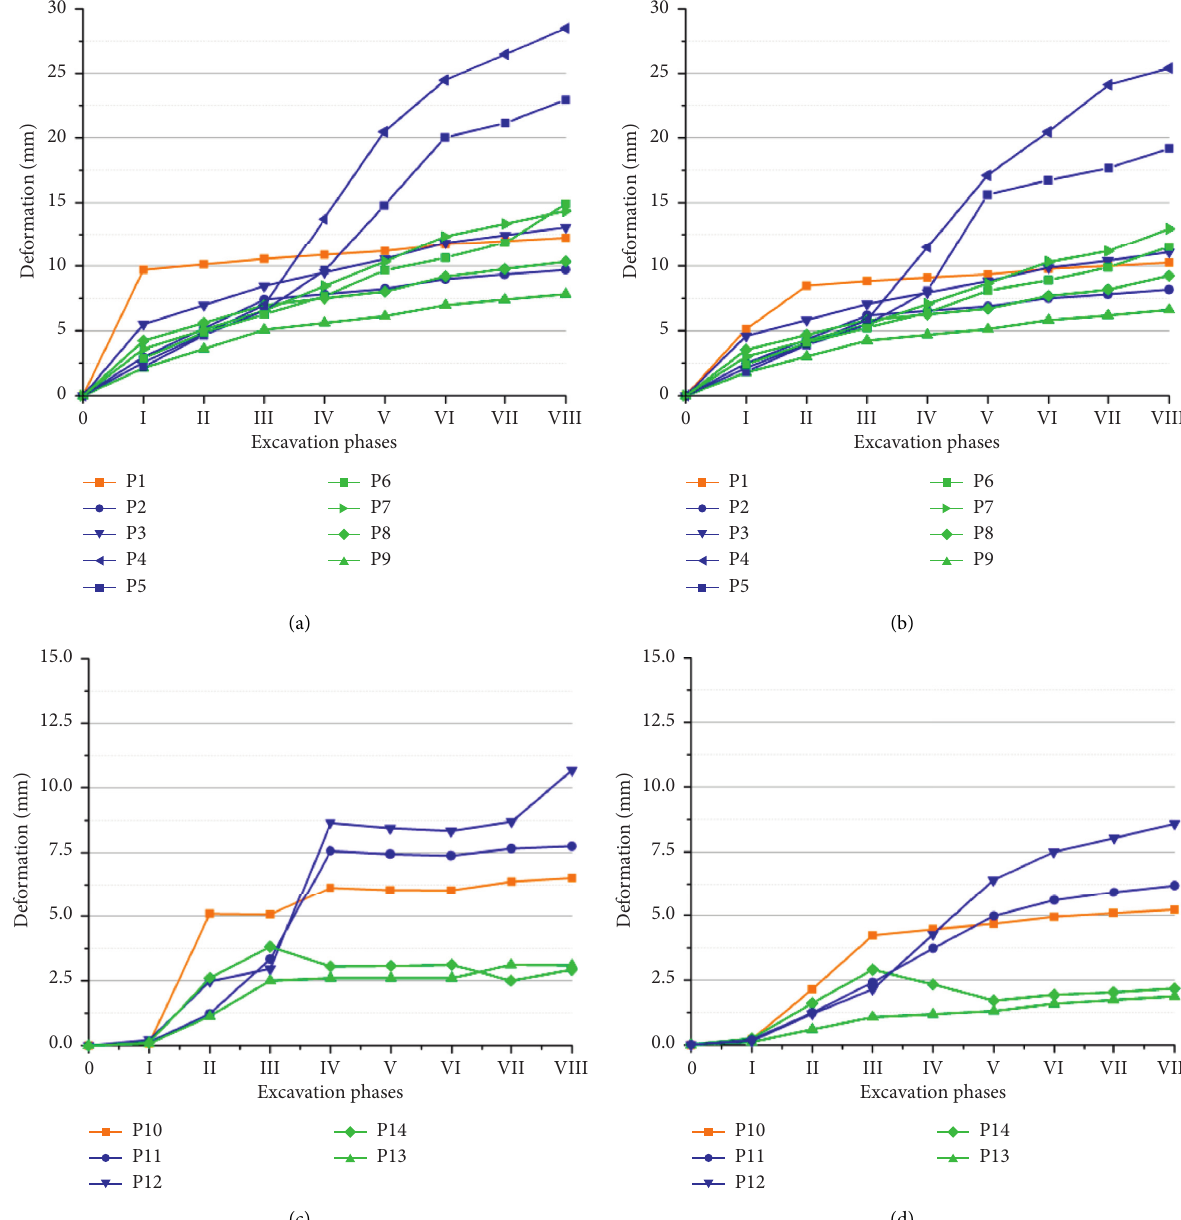
Figure 11: Displacement without (a and c) or with (b and d) support of the key monitoring points of the main powerhouse and transformer